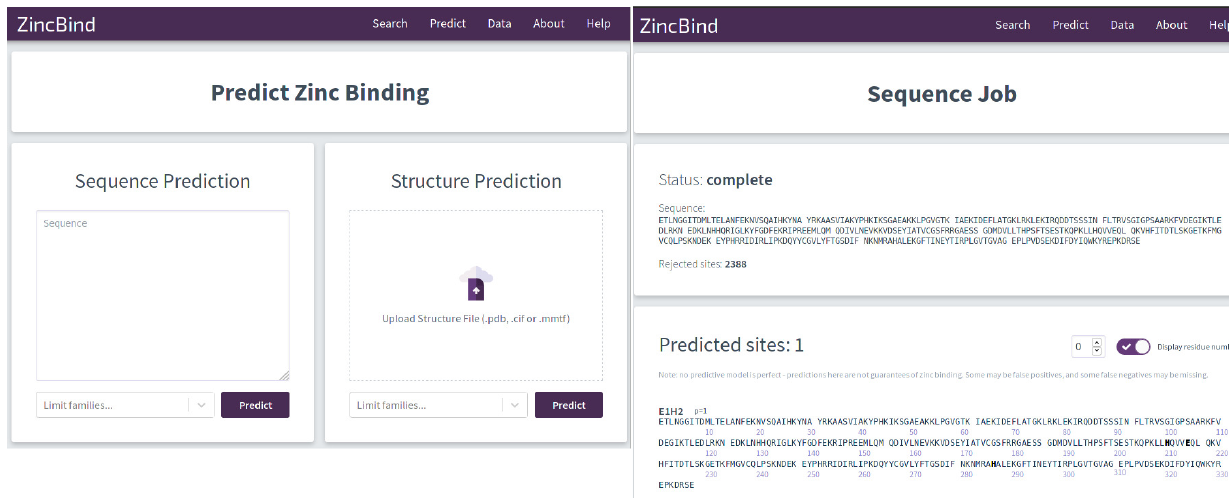
Figure 1. The graphical interface for the predictors is shown on the left. The user can enter a protein sequence, or upload a structure file. In both cases, the user has the option of limiting the zinc binding families for which the predictor will search, which can save a considerable amount of time. Results of the prediction are shown on the right with the residues predicted to form a binding site shown in bold. This interface consumes the ZincBindPredict GraphQL application programming interface (API), which is also publicly